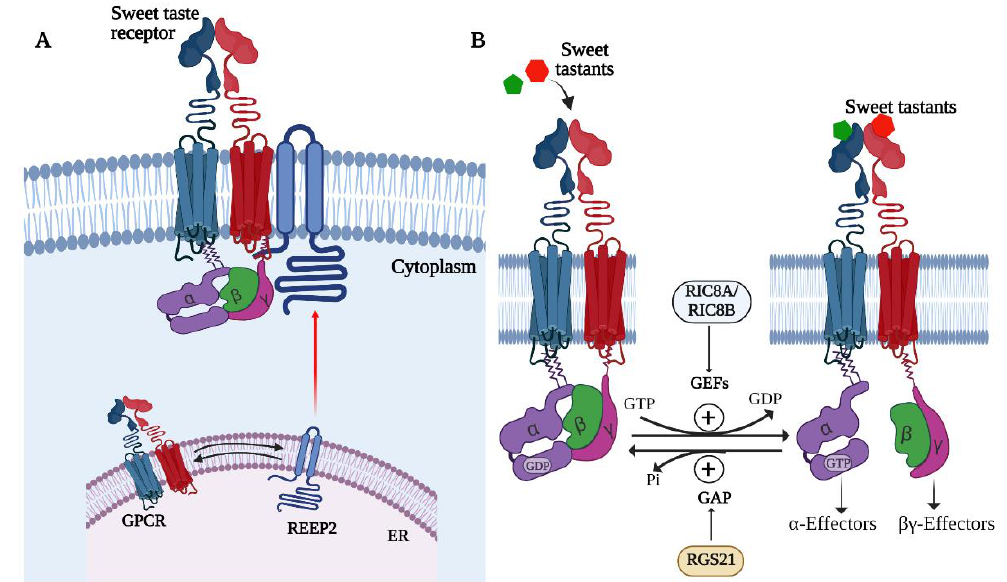
Figure 2. Accessory proteins regulating STR signaling. ( A ) REEP2 is a chaperone protein that noncovalently interacts with the STR and targets it to the plasma membrane. REEP2 may promote the localization of the STR to lipid rafts, which are thought to be specialized cholesterol and sphingolipid-rich microdomains in the plasma membrane where signaling complexes are assembled. ( B ) G-protein-interacting proteins regulate G-protein activity by modulating GTP binding or hydrolysis by the Gα subunit. Guanyl nucleotide exchange factors such as R1C8A and RIC8B may promote the exchange of GTP for GDP, thereby activating G-protein signaling, whereas GTPase-activating proteins such as RGS21 activate GTP hydrolysis to terminate G-protein signaling downstream of the STR. Part B adapted with permission from Siderowski and Willard [79].